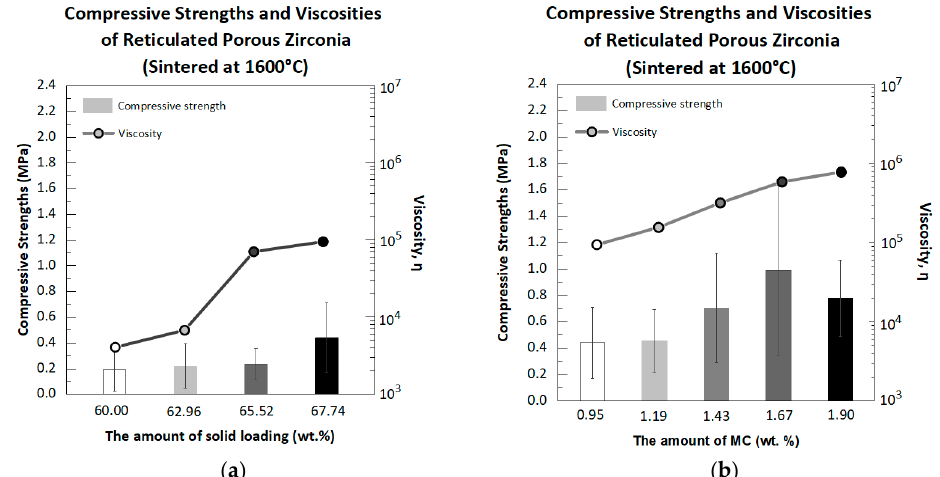
Figure 3. Viscosity at a shear rate of 0.01 s-1 of the zirconia slurry, and the compressive strengths: ( a ) 60–67.74 wt.% solid loading; and ( b ) 0.95–1.90 wt.% MC .